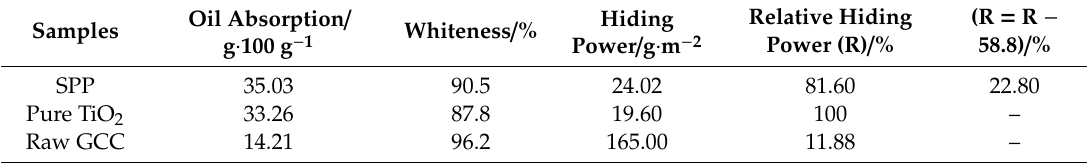
Table 1. Pigment performance comparison of SPP, pure TiO 2 pigments and raw